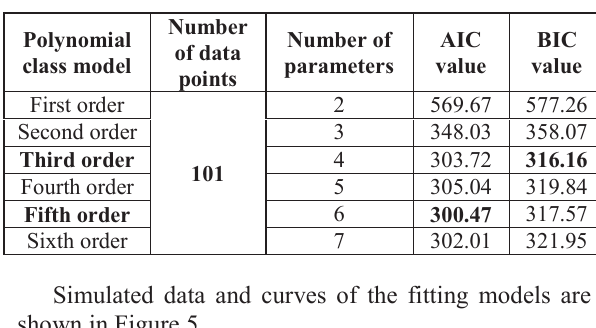
Table 3. Result with large sample (101 points).